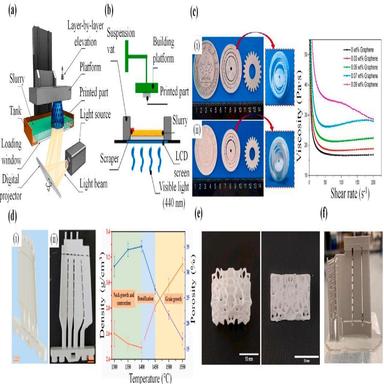
Schematic diagrams of DLP technology (a) and LCD technology (b) and the research advances: (c) DLP-printed raw and sintered samples of Al2O3 and the viscosity of different graphene-content Al2O3 slurries, (d) DLP-printed Al2O3 ceramic cores for precision casting of hollow turbine blades and their porosities and bulk densities versus sintering temperature, (e) DLP-printed Alumina/based apatite composite ceramic structural parts and samples after sintering, (f) LCD-pr